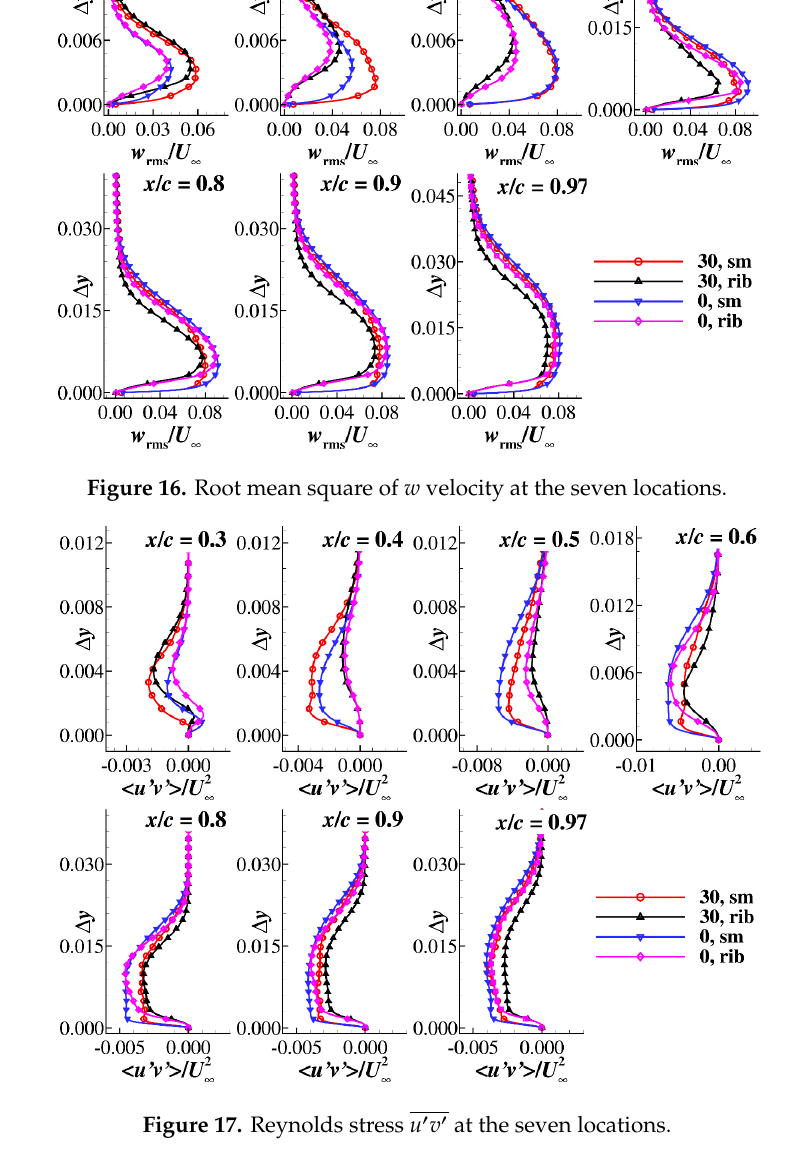
Figure 17. Reynolds stress u (cid:48) v (cid:48) at the seven locations.